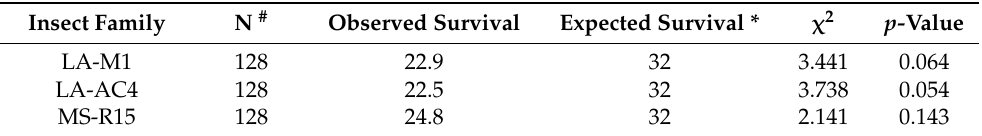
Table 5. Test for feral male moths of Helicovepa zea containing two recessive resistance alleles in the F 2 screen.